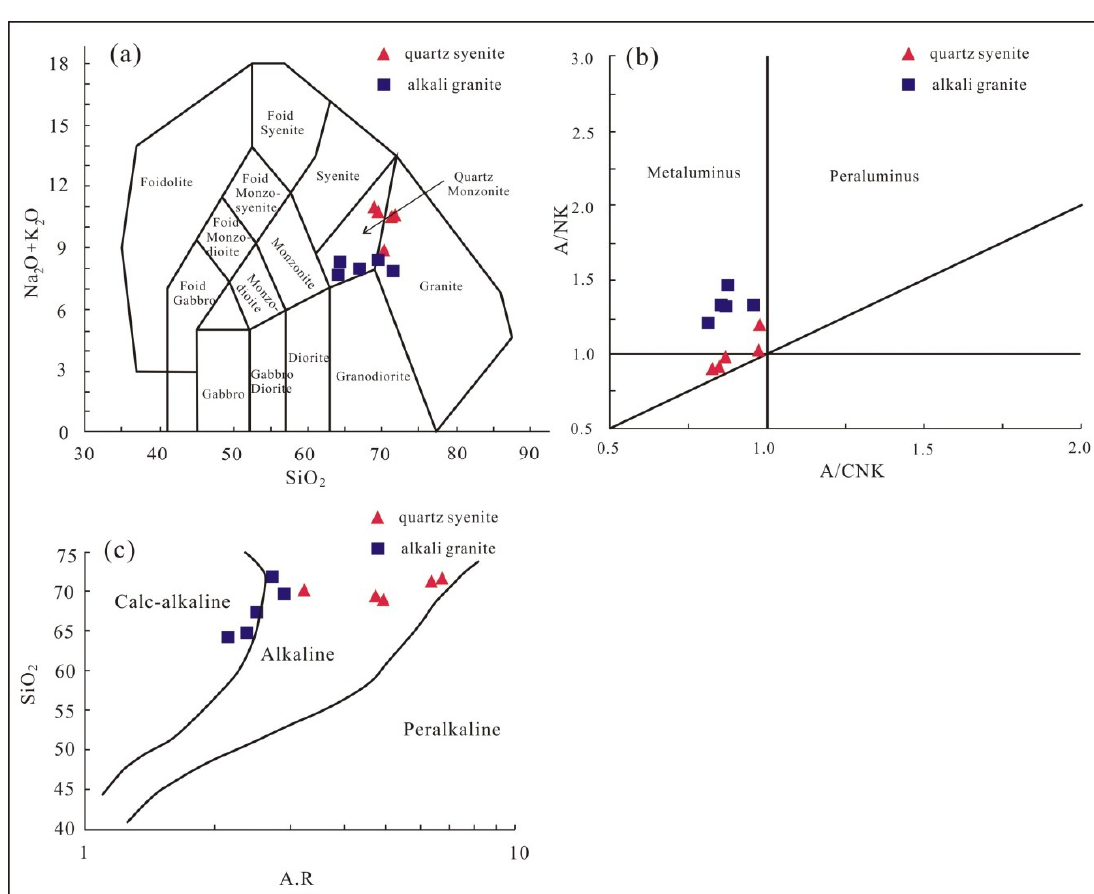
Figure 4. Plots of SiO 2 vs. Na 2 O + K 2 O ( a ), A/NK (molar ratio Al 2 O 3 /(Na 2 O + K 2 O)) vs. A/CNK (molar ratio Al 2 O 3 /(CaO + Na 2 O + K 2 O)) ( b ), and SiO 2 vs. A.R (Al 2 O 3 + CaO + (Na 2 O + K 2 O))/(Al 2 O 3 + CaO – (Na 2 O + K 2 O)) ( c ) of the Chishan alkalic complex. (a) is from [56], (b) is from [57], and ( c ) is from [58].